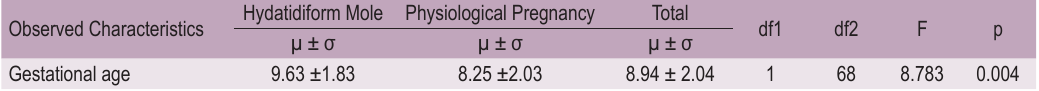
TABLE 6. Difference in the average gestational age of pregnancy in the groups Observed